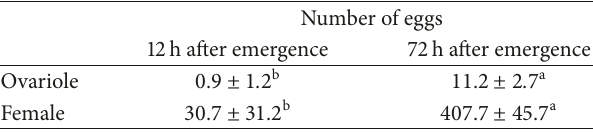
Table 1: Egg (immature + mature eggs) number (mean number ± three days old at the moment of